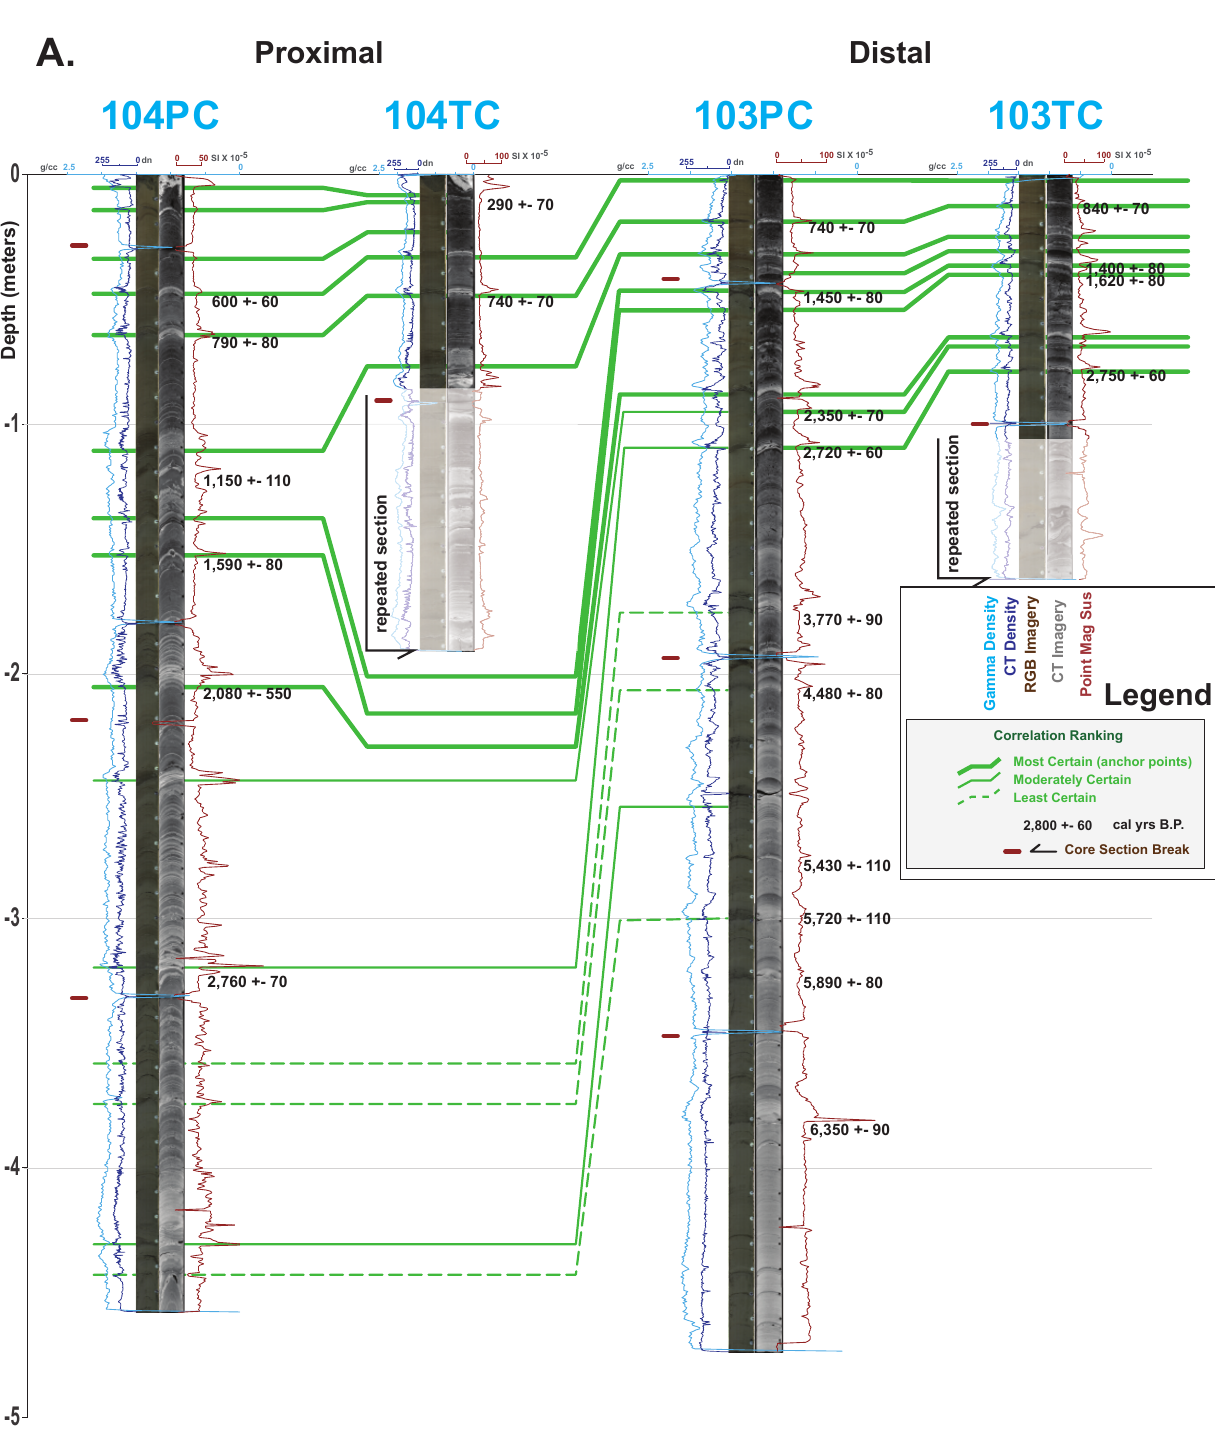
Fig. 5. Sumatra slope basin cores RR0705-104PC and RR0705-103PC. As in all figures and throughout this paper: PC, = Piston core; BC, Box core; KC, Kasten core; GC, Gravity core; MC = Multi core. (A) Stratigraphic correlations between these cores using lithology, CT, geophysical properties, and 14 C data. Multi Sensor Core Log (MSCL) data are plotted beside RGB imagery and CT imagery that displays lower density material in darker grey and higher density material in lighter grey. Gamma density, CT density, point magnetic susceptibility, and loop magnetic susceptibility are plotted left to right as light blue, dark blue, dark red, and light red. Radiocarbon ages are calibrated and reported with 95% error as is true for all ages in this paper (Table S1). “Repeated section” refers to strata that have been double cored. This happens when the trigger core barrel is inserted into the sea floor twice or more due to ship heave, thus sampling the same sediments twice or more (104TC has double repeated